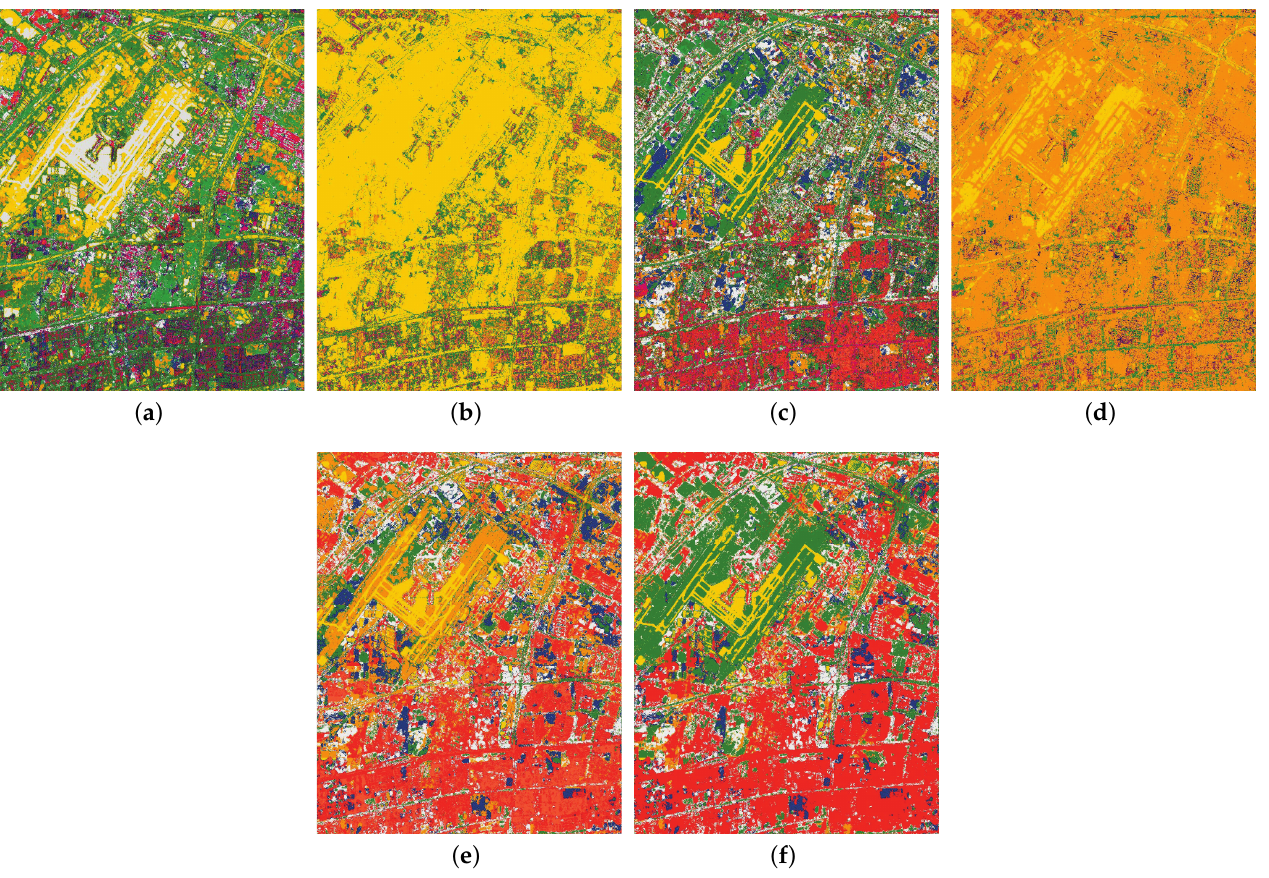
Figure A12. Classification results of different algorithms and class numbers. ( a ) Result of H / A / α - Wishart with 16 classes. ( b ) Result of H / A / α -Wishart with 5 classes. ( c ) Result of h / q / gray -Wishart with 16 classes. ( d ) Result of h / q / gray -Wishart with 5 classes. ( e ) Result of the proposed with 16 classes. ( f ) Result of the proposed with 5